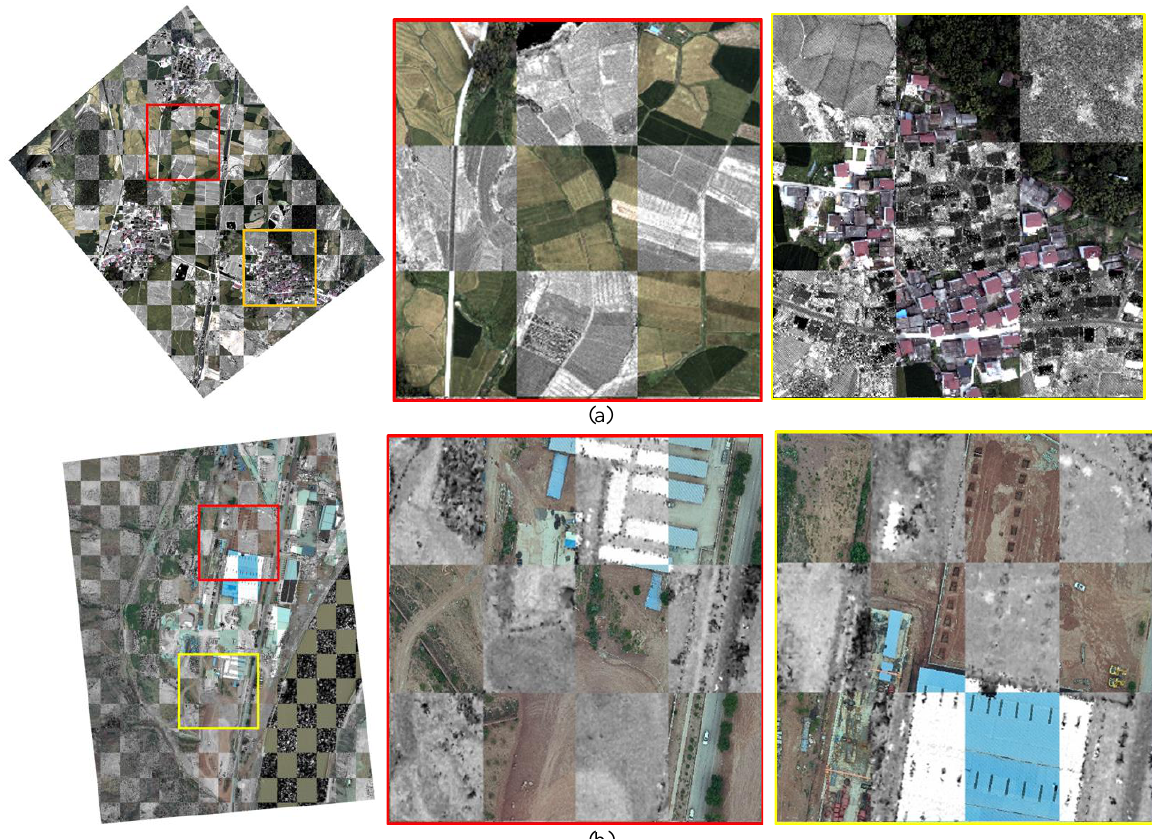
Figure 10. Checkboard visualization of registration results. (a) Checkboard map of the registration result of test 1. (b) Checkboard map of the registration result of test